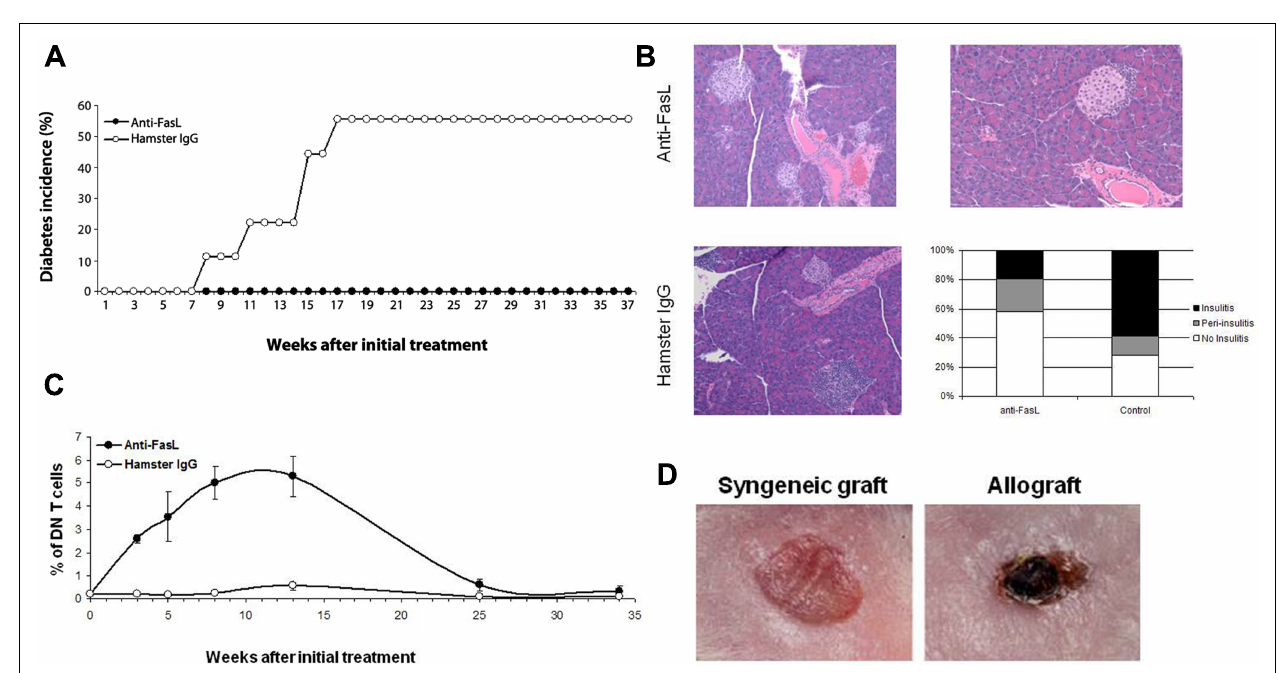
FIGURE 3 | Single gld allele provides complete protection from diabetes without causing lymphoproliferation. (A) Images of spleens and peripheral lymph nodes of NOD mice bearing homozygous (gld/gld), heterozygous (gld/ + ) mutation or wt (WT) FasL. (B) Homozygous and heterozygous gld mutations completely prevent diabetes in NOD mice as compared to NOD-wt littermates. NOD mice bearing homozygous gld